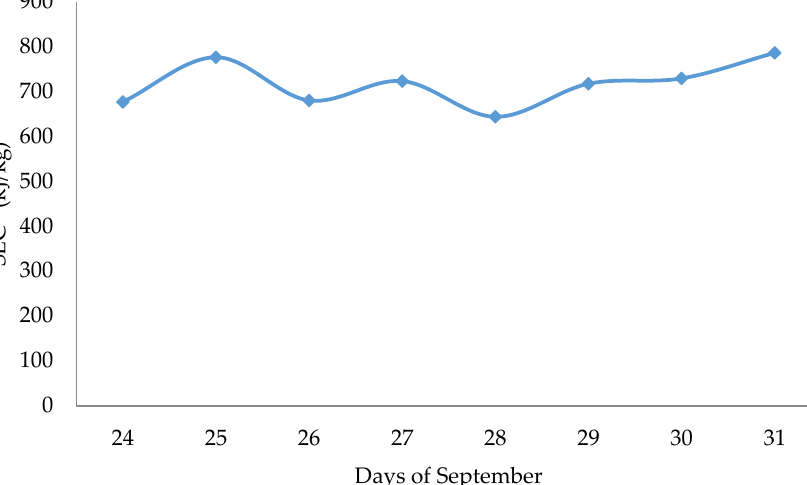
Figure 11. Measured SEC for the solar MSF system between 24th and 31th September.